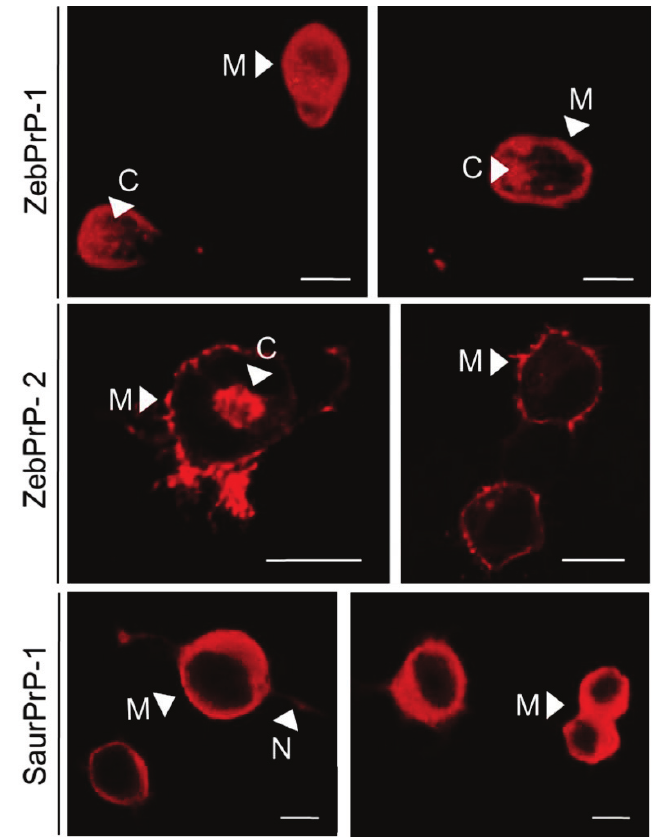
Figure 3. Indirect immunofluorescence of ZebPrP1, ZebPrP2 and SaurPrP1 in N2a cells indicates murine-like intracellular processing and localization. Fluorescent immunolabelling of N2a cells transfected with ZebPrP-1 and incubated with ZebPrP1 antiserum (1:750, upper panel), transfected with ZebPrP-2 and probed with ZebPrP2 polyclonal antibody (1:1500, middle panel) and, finally, transfected with SaurPrP-1 and incubated with SaurPrP1 antiserum (1:1000, lower panel). M, plasma membrane; C, cytoplasm; N, neurite. Scal e bars, 10